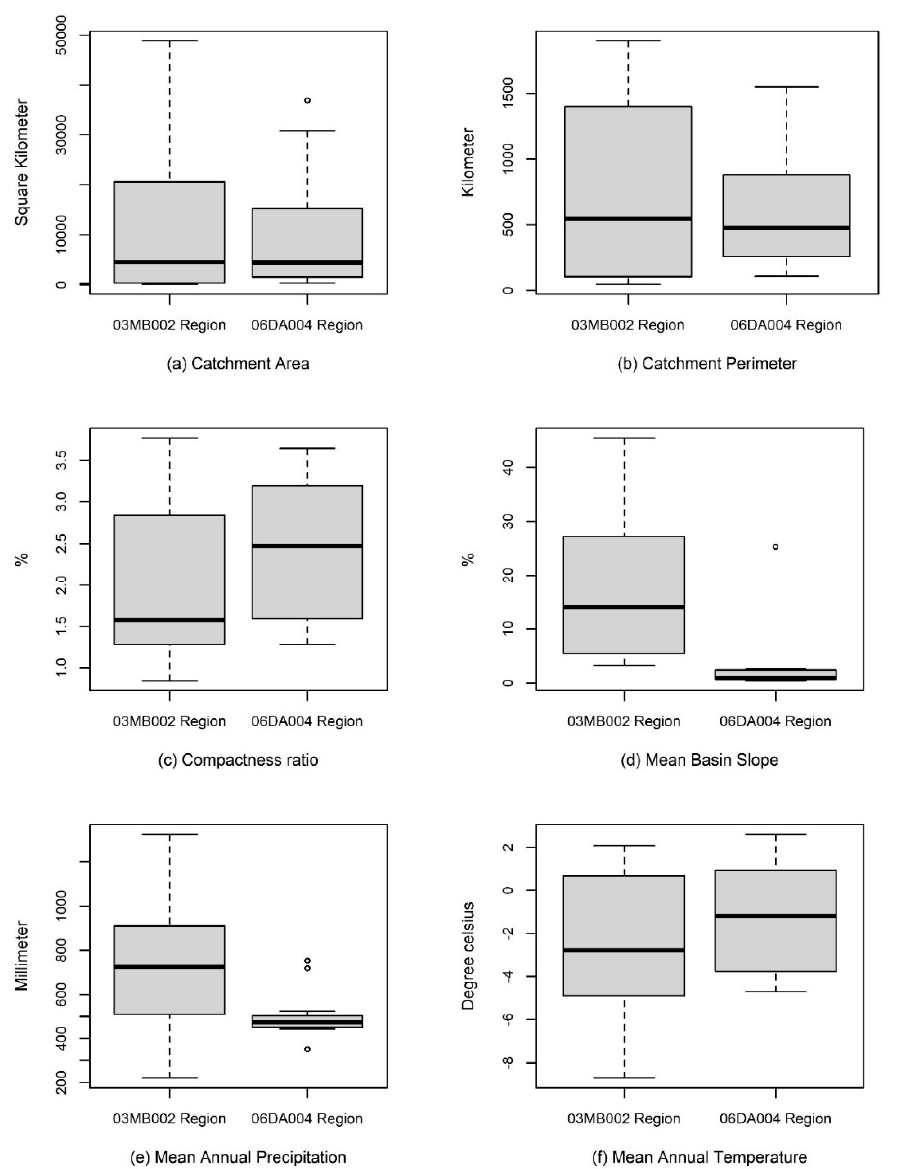
Figure 8. Boxplots for physiographic variability of 03MB002 and 06DA004 flood regions. Boxes represent 25th/75th percentiles with the median (black line); whiskers extend to the extreme values without outliers; outliers (circles in plot) are defined as 1.5 the interquartile range.